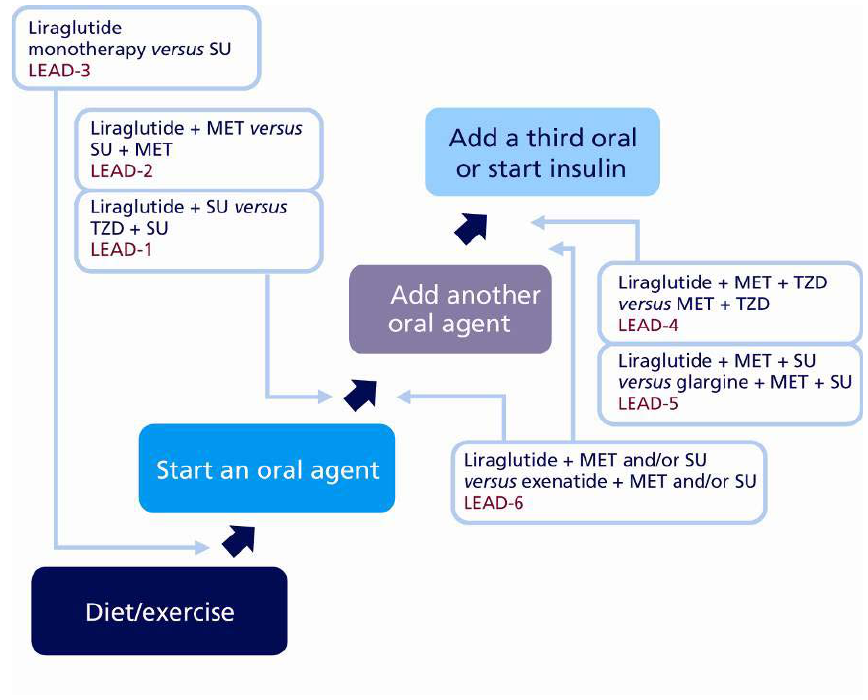
Figure 6. Liraglutide Implementation Throughout the Continuum of